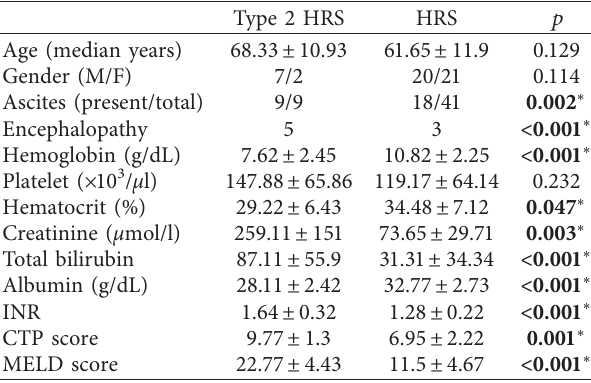
Table 1: Patients CTP groups.